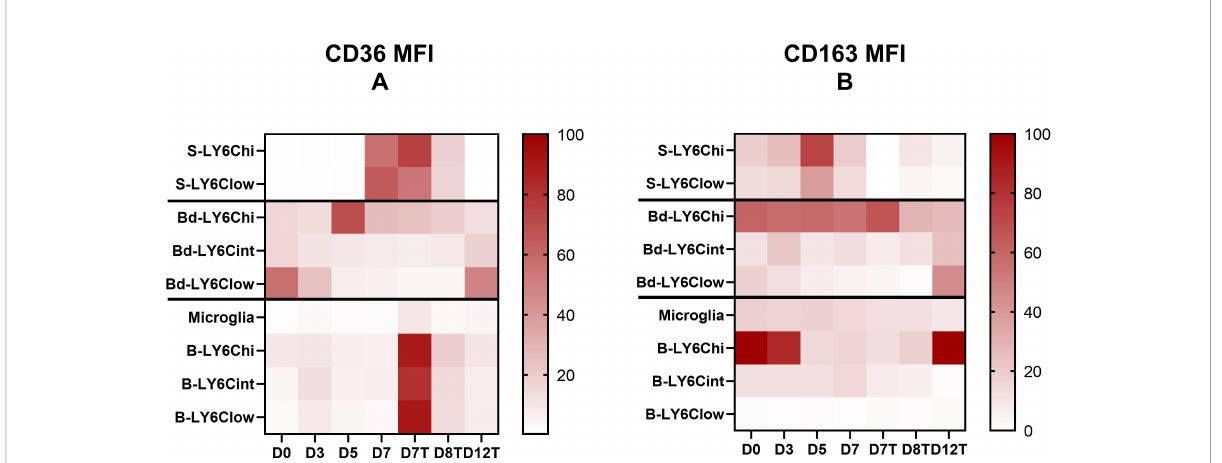
FIGURE 3 CD36 and CD163 receptors are differentially expressed in terms of expression level and evolution during the kinetics of infection and its resolution by the monocyte subpopulations from one compartment to another. (A, B) Mean fl uorescence intensity (MFI) of CD36 (A) and CD163 (B) by the different Ly6C monocyte subpopulations and the microglia characterized in the spleen, blood, and brain were analyzed using FlowJo during Plasmodium berghei ANKA infection in chloroquine (CQ)-treated and untreated mice. To obtain comparable data during kinetics between the different subpopulations of each compartment studied (i.e., the spleen, blood, brain), the heatmap presents the data as a ratio to the highest MFI value obtained during the kinetics ×100 for each